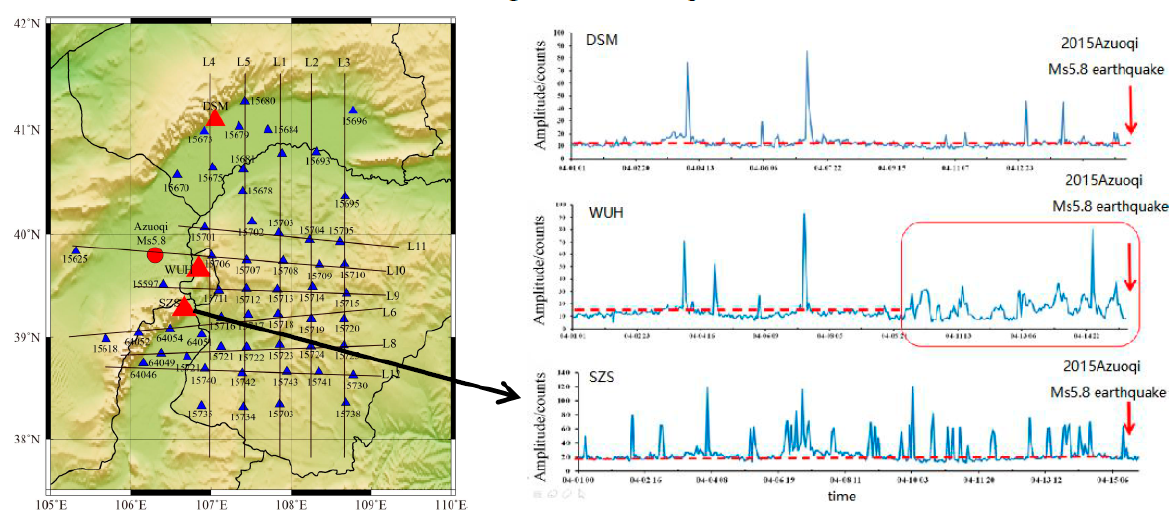
Figure 15. Low-frequency signal characteristics and 64052 in L6 line = SZS.